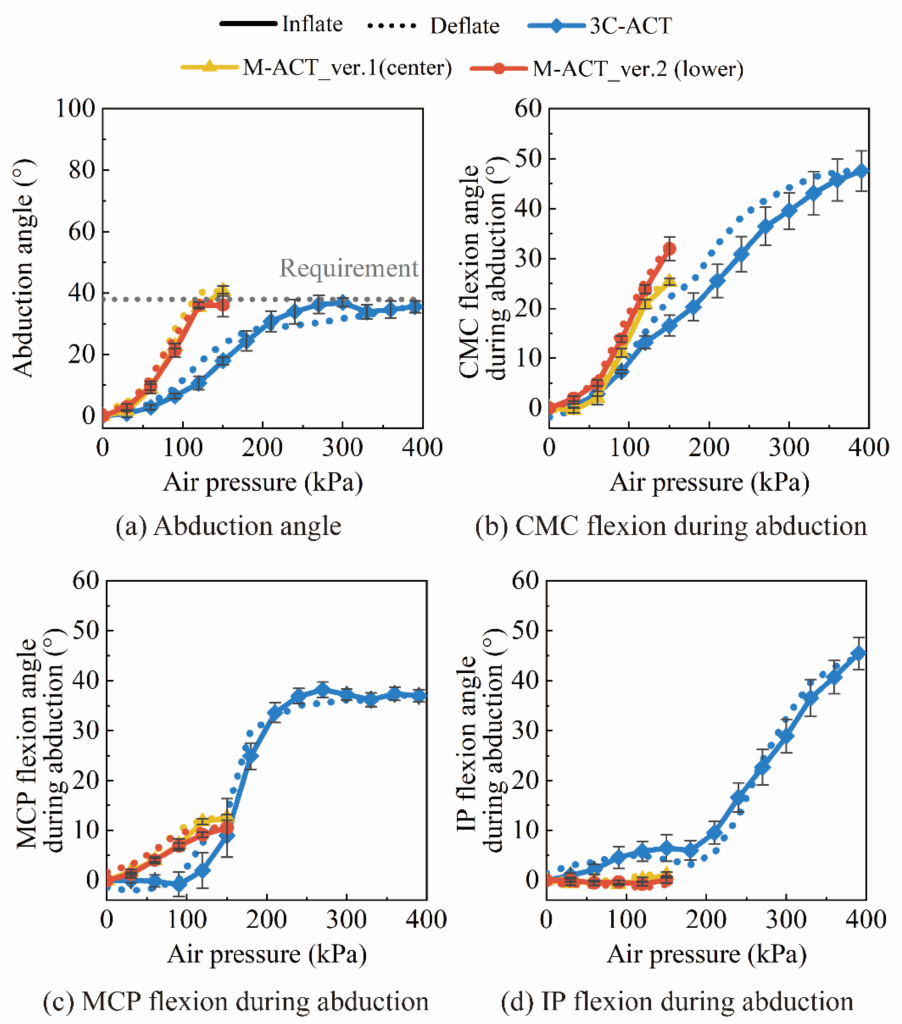
Figure 4. The thumb abduction and flexion RoM during left-side chamber/module air inflation. CMC: carpometacarpal; MCP: metacarpophalangeal; IP: